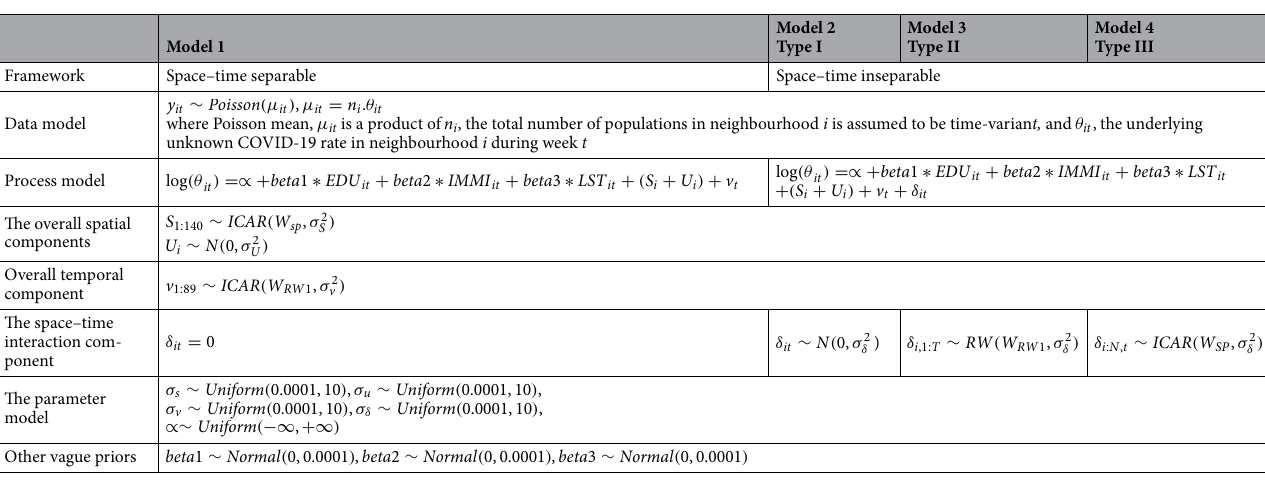
Table 2. Summary of the four Bayesian space–time hierarchical models. where beta 1, beta 2 and beta 3 are the regression coefficients of higher education rate, percentage of immigrants and LST, respectively. S i is the structured, U i is the unstructured, v t is the temporal and δ it is the space–time interaction effect. σ s , σ u , σ v , σ δ are the standard deviation of the spatially-structured, spatially-unstructured, temporal and space–time random effect terms, respectively. 1 /σ 2 s , 1 /σ 2 u , 1 /σ 2 v 1 /σ 2 δ are the precision parameters. ICAR Intrinsic Conditional Autoregressive, RW Random Walk